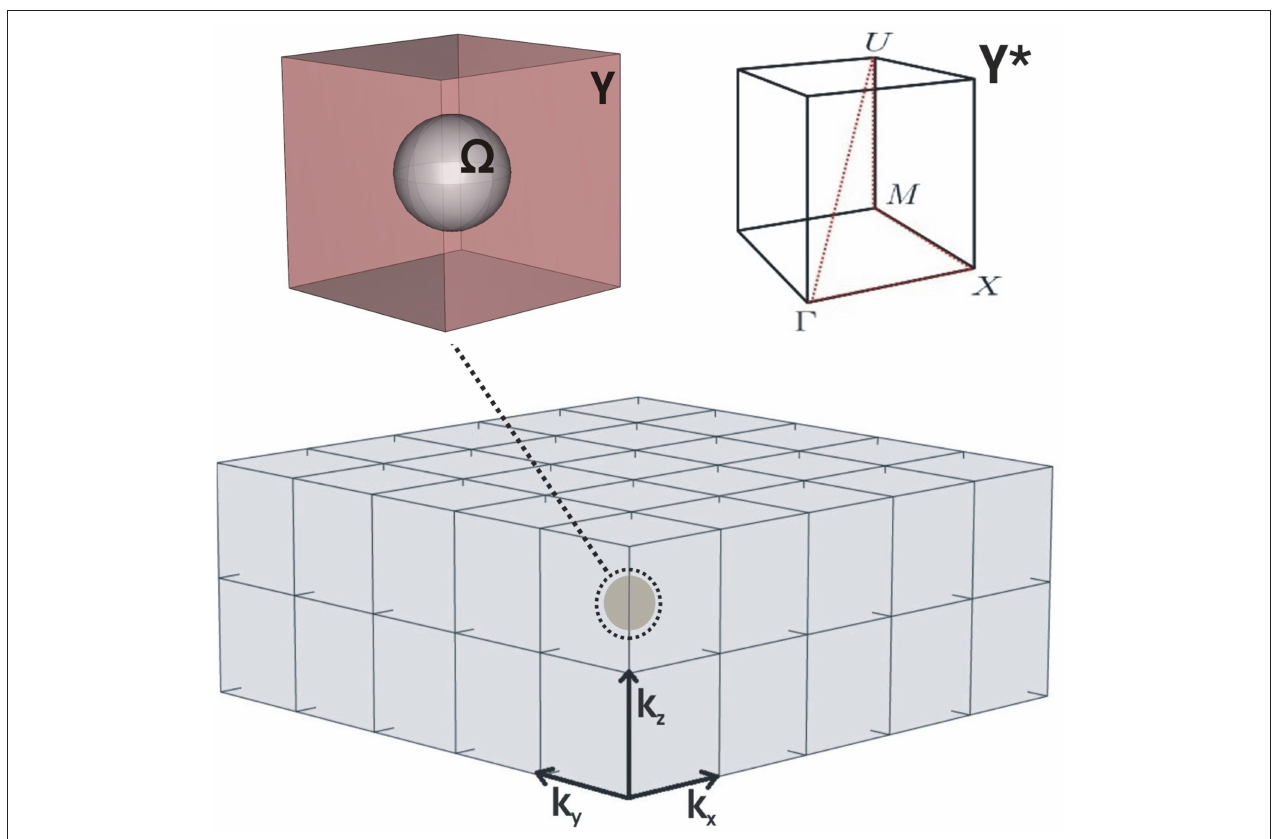
FIGURE 1 | Three-dimensionnal phononic crystal, periodic cell Y with a rigid sphere (cid:127) in physical space and irreducible Brillouin zone Ŵ XMU of the periodic cell Y ∗ in reciprocal space with the three components of the Floquet-Bloch vector k